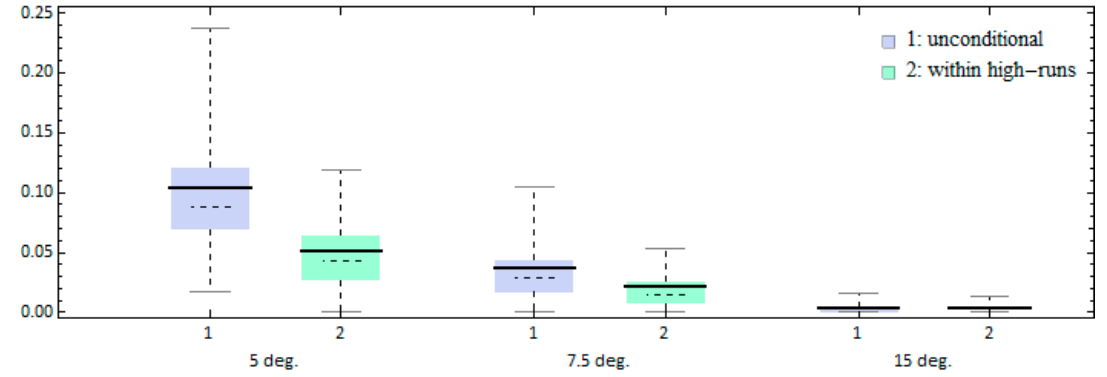
Figure 13. Effect of selected yaw threshold limit on the time-ratio of yaw exceedance ( Κ G = 7.25 m).